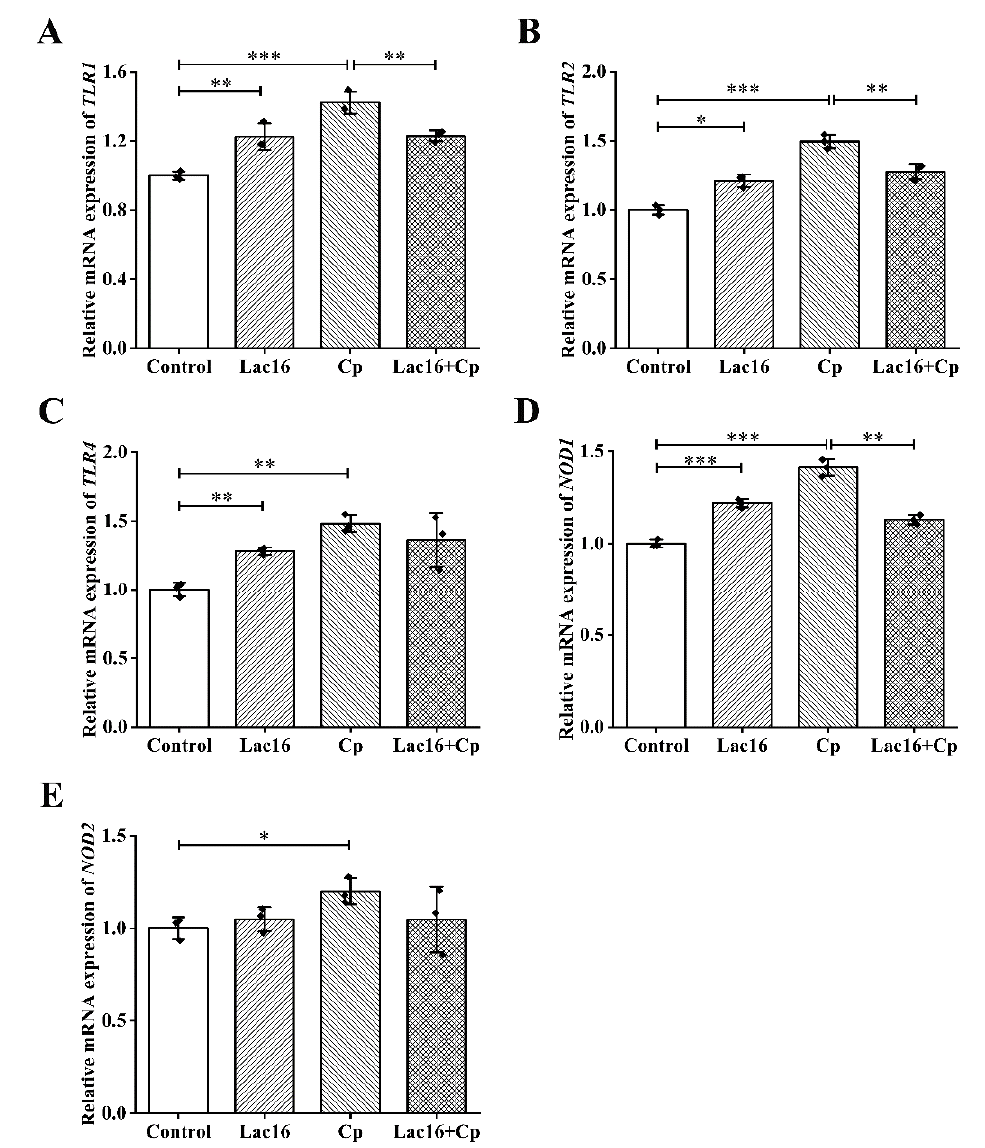
Figure 6. Relative gene expression levels of PRRs during C. perfringens infection in IPEC-J2 cells preincubated with L. plantarum Lac16. ( A ) TLR1 , ( B ) TLR2 , ( C ) TLR4 , ( D ) NOD1 , ( E ) NOD2 . mRNA expression was standardized to β -actin expression. Data are presented as the means ± SD for n = 3; * p < 0.05, ** p < 0.01, *** p < 0.001 ( t test).